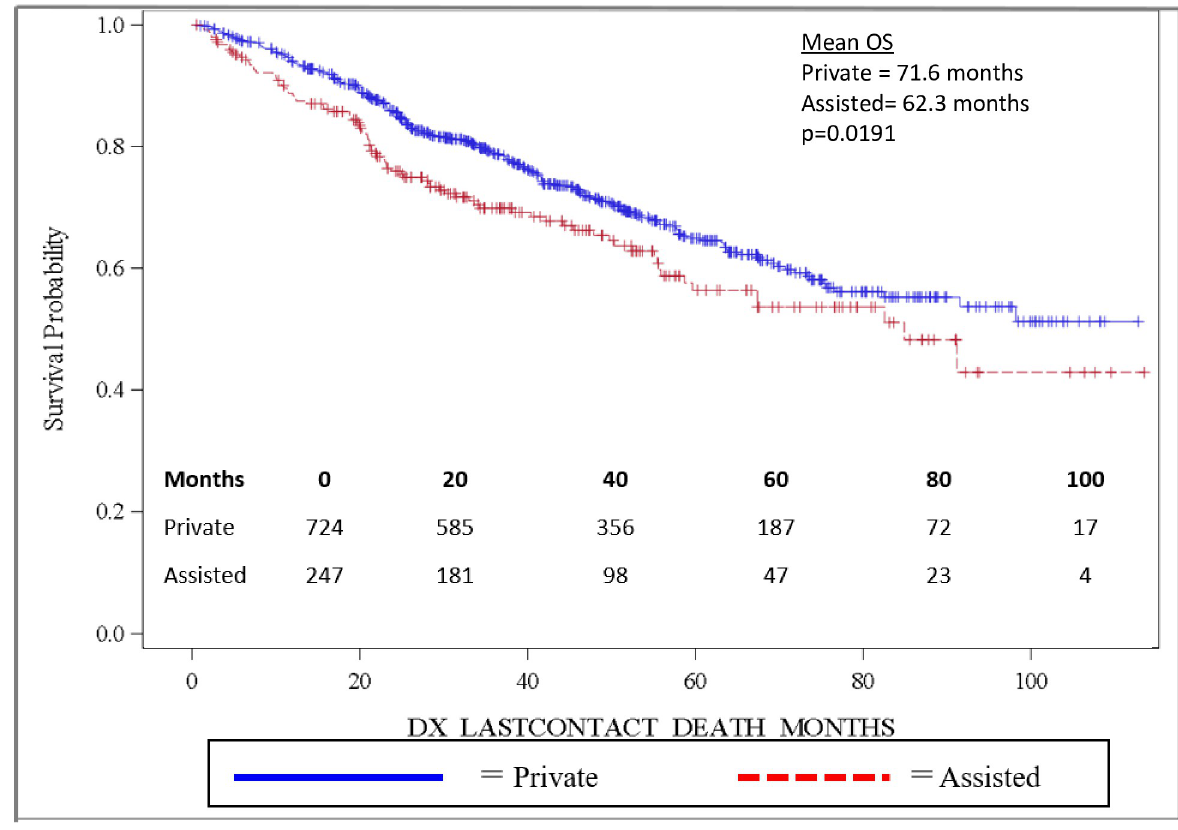
Fig 4. Overall survival by insurance